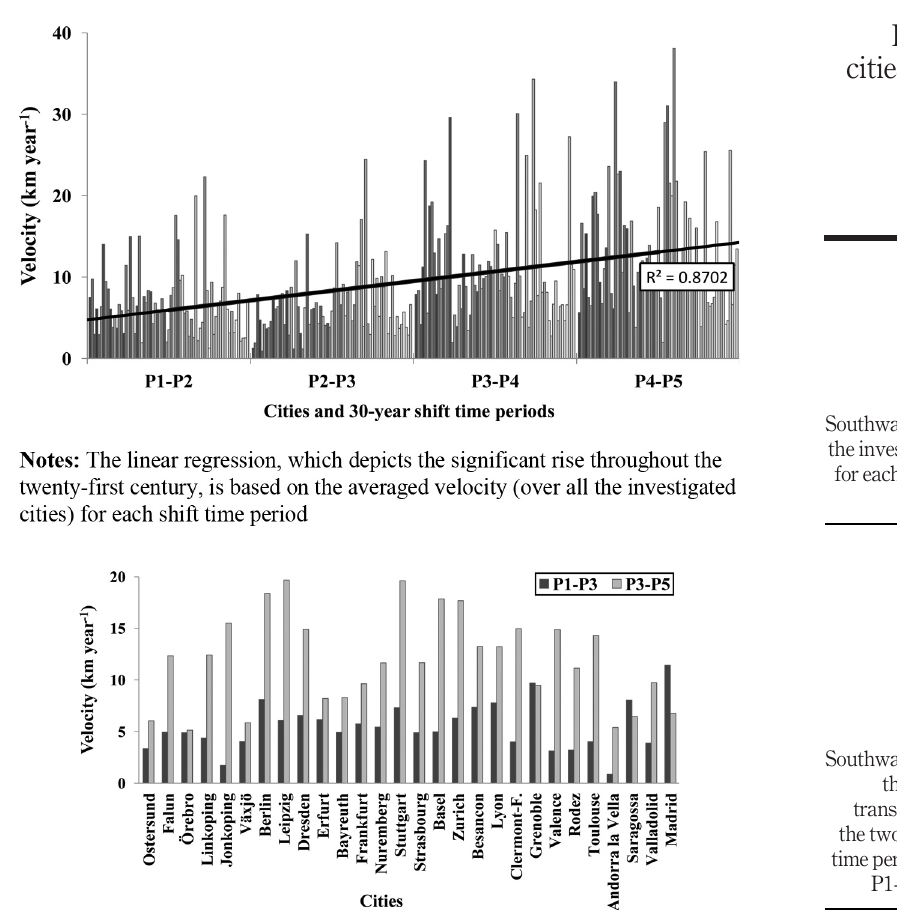
Figure 5. Southward velocity of the Continental transect ’ s cities for the two 60-year shift time periods, namely, P1-P3 and P3-P5